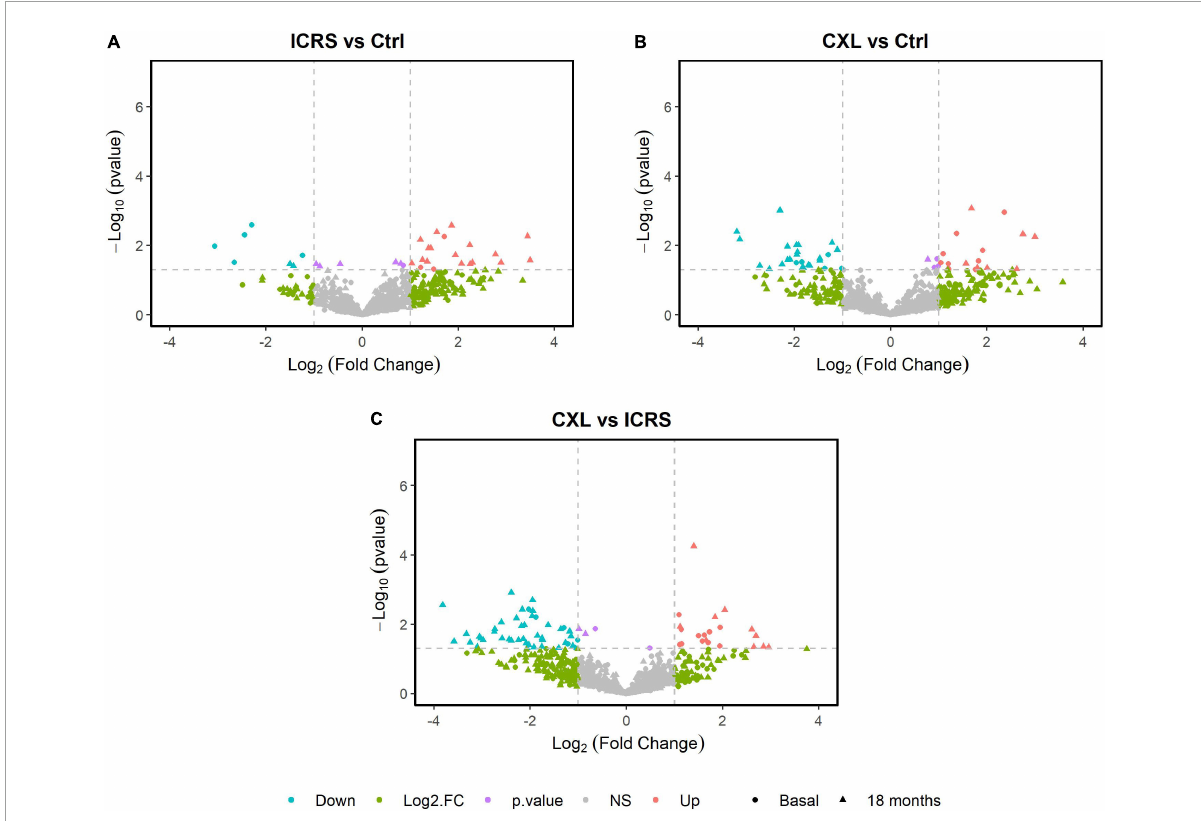
FIGURE1 Volcano map of protein expression was performed for the pairwise comparison of the three groups; ICRS vs. Ctrl (A) , CXL vs. Ctrl (B) , and CXL vs. ICRS (C) , differentiating between the two time periods considered (Baseline and 18